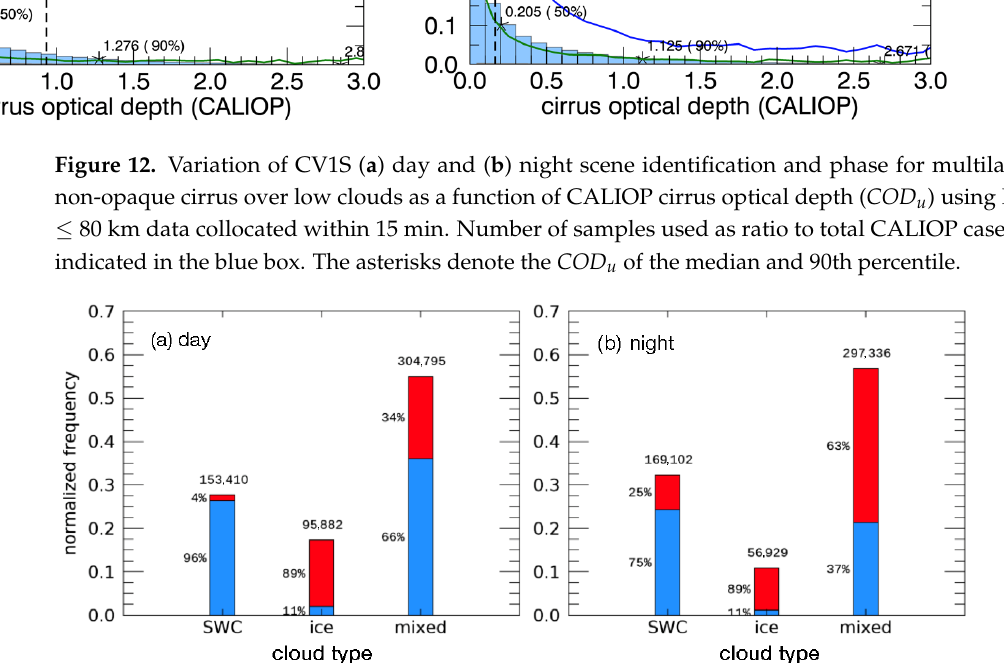
Figure 13. CV1S classification of ( a ) day and ( b ) night clouds having effective temperatures between 0.0 °C and − 40 °C for three different categories liquid, ice, and mixed phase clouds as determined from CALIOP profiles using the method of [30]. Percentages of each CALIOP category classified by CV1S as liquid or ice cloud are indicated in blue and red, respectively.